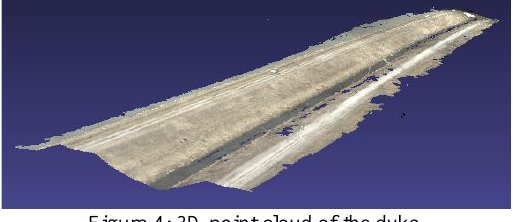
Figure 4: 3D point cloud of the dyke.